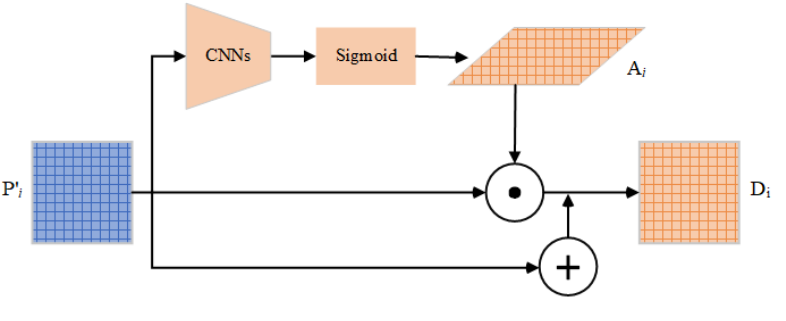
Figure 5. Detailed information on the multi-feature selection module. CNNs: four layers of 3 × 3 convolution, (cid:12) : Hadamard product, ⊕ Matrix